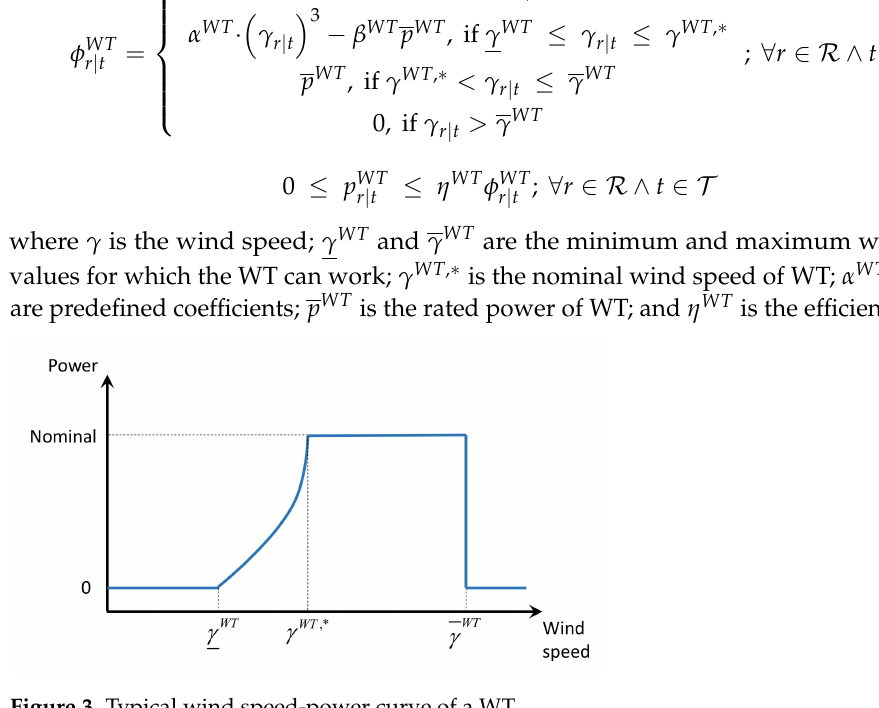
Figure 3. Typical wind speed-power curve of a